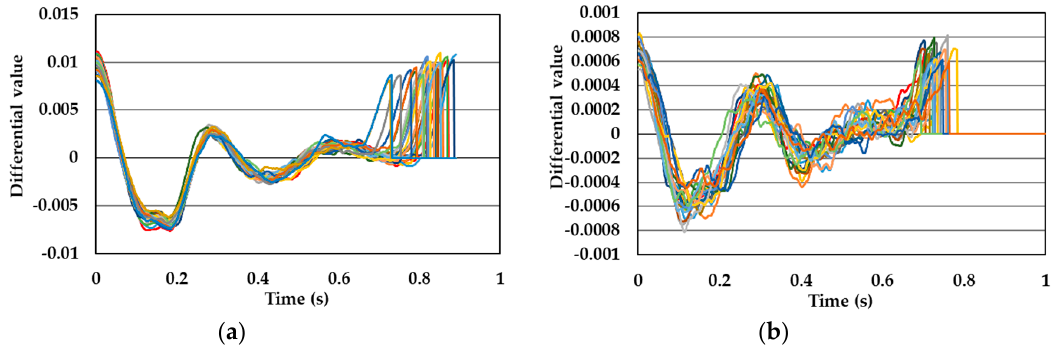
Figure 8. The single pulse wave signals of subject D: ( a ) POF-FBG sensor and ( b ) silica-FBG sensor.